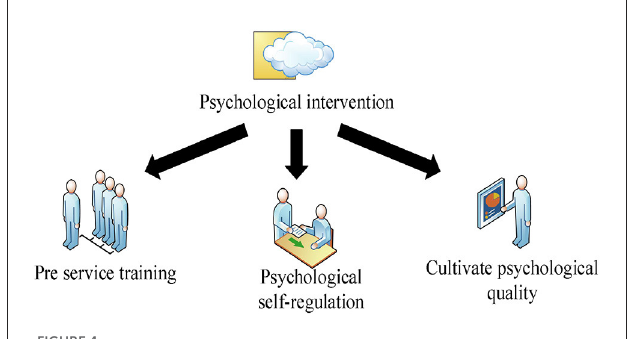
FIGURE3 Problems exposed by civil servants in response to emergencies.